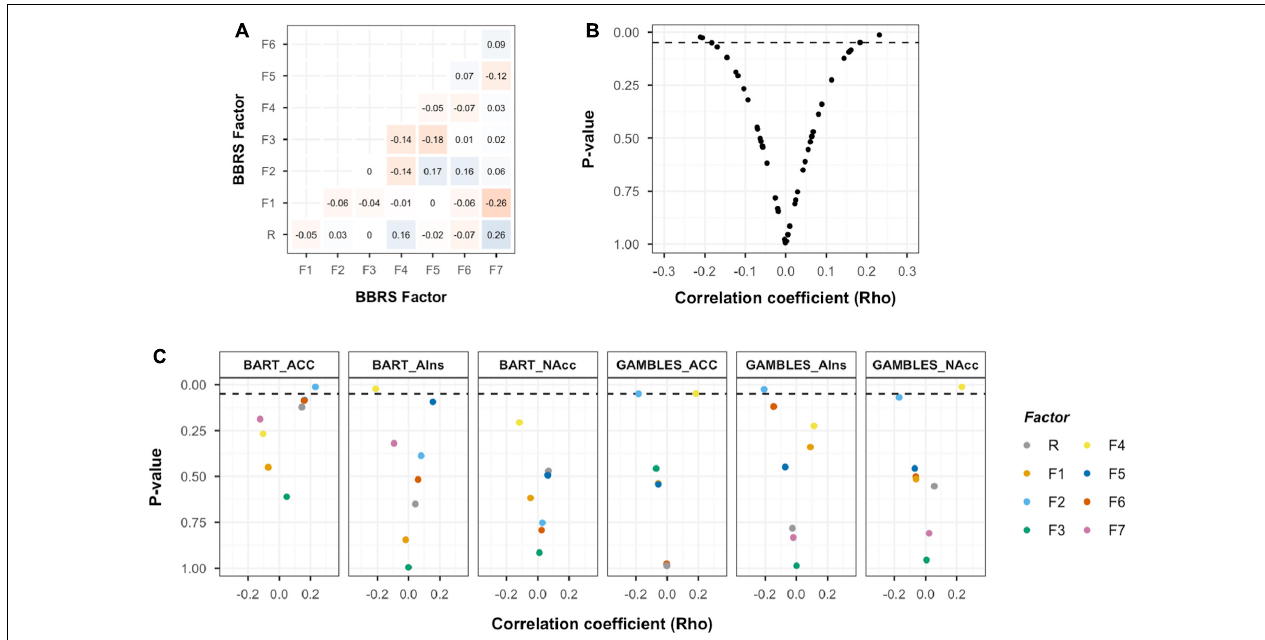
FIGURE 5 | Basel–Berlin Risk Study (BBRS) risk preference factors and association with neural markers of risky choice. (A) Pearson correlation coefficients for associations between risk preference factors in the BBRS imaging subsample ( N = 116). (B) Scatterplot for correlation coefficients and associated p -values for brain–behavior associations. Dashed line represents significance level of p < 0.05 (uncorrected for multiple testing). (C) Scatterplot for correlation coefficients and associated p values for all brain–behavior associations, organized by region of interest (ROI) and colored by risk preference factor. Dashed line represents significance level of p < 0.05. Balloon Analog Risk Task (BART) mean activation extracted from “Pumps reward > Pumps control” contrast; GAMBLES mean activation extracted from “Accept > Reject” contrast; ACC, anterior cingulate cortex; AIns, anterior insula; NAcc, nucleus accumbens; R, general risk-preference factor; F1, health